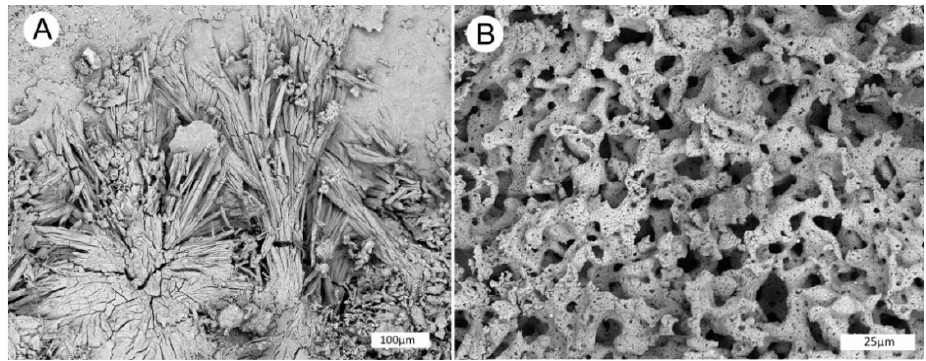
Figure 14. SEM BSE images of light-colored encrustations reveal two forms. ( A ) Prismatic crystals of aluminum sulfate. ( B ) porous coral-like ferruginous aluminum sulfate.